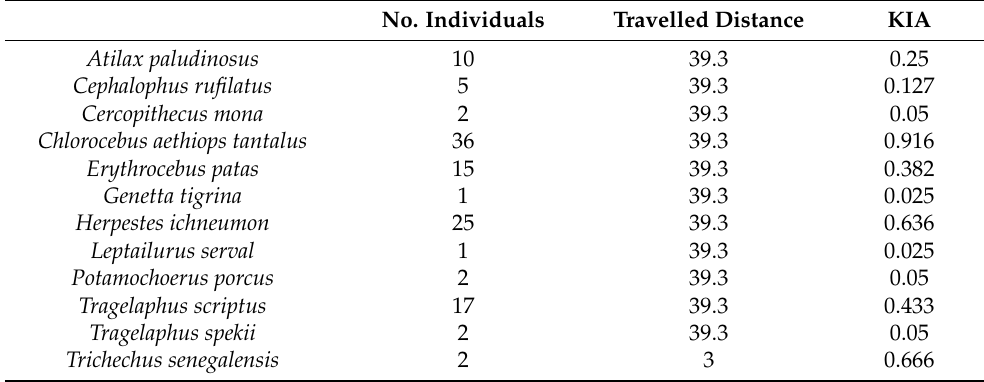
Table 2. Diversity and Kilometric Index of Abundance (KIA) estimates for the various species of mammals in the Av é v é forest